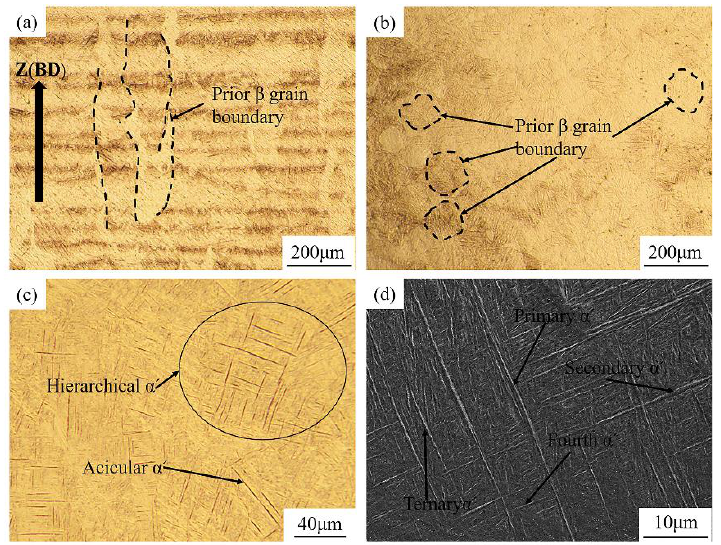
Figure 3. Microstructure of the as-built TA15: ( a ) OM micrograph of the vertical plane, ( b ) OM micrograph of the horizontal plane, ( c ) higher magnification of OM micrograph and ( d ) SEM micrograph of the vertical plane.